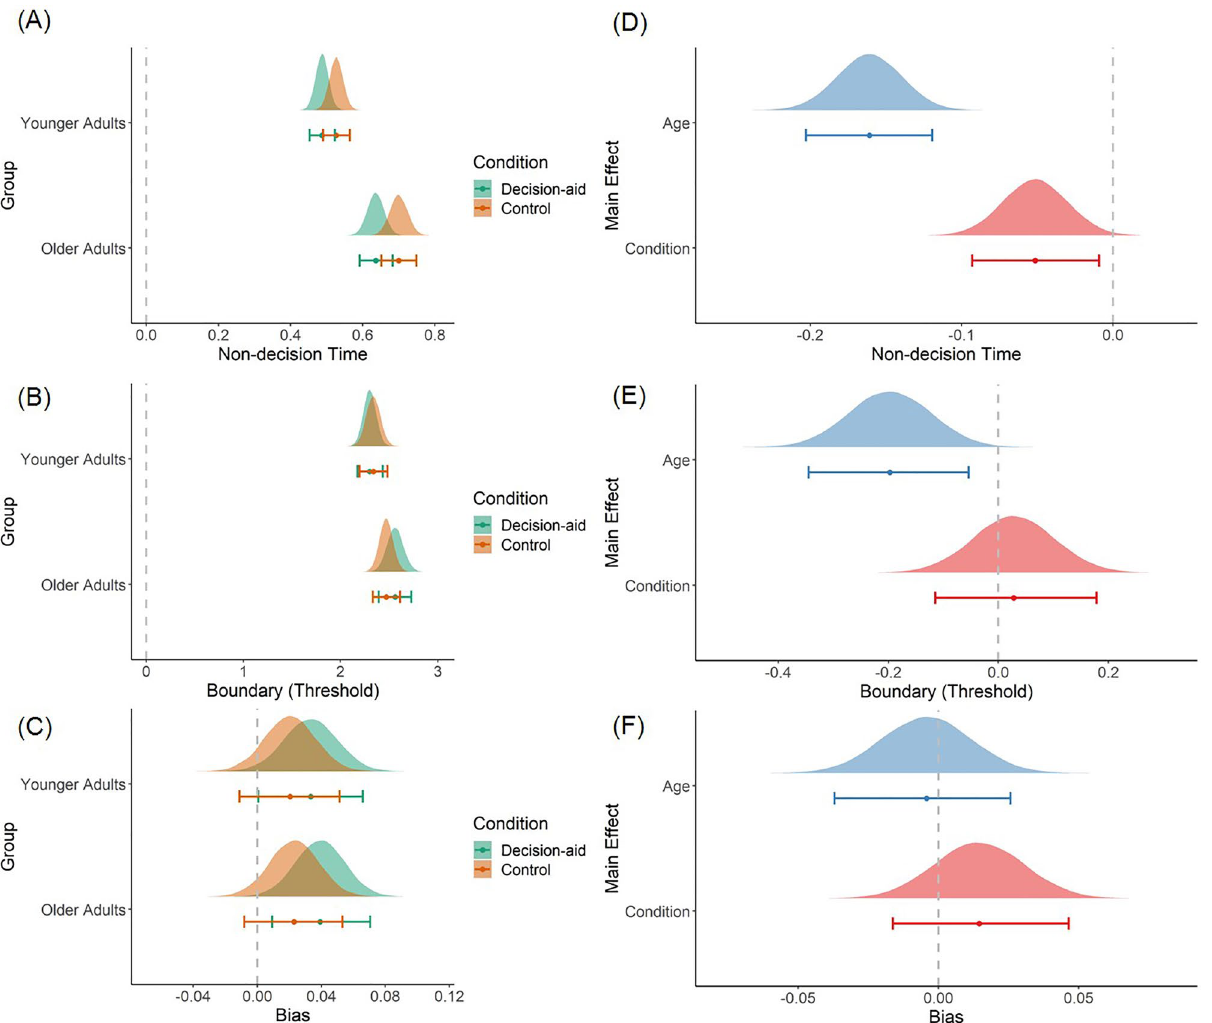
Figure 3. Effects of age group and condition on the non-decision time, boundary separation (threshold), and starting point bias parameters of stDDM (M3). ( A – C ) Posterior distributions of the group-level parameters from the best fitting model (M3) in all experimental conditions in both age groups. ( D – F ) Age and condition differences of the posterior distributions of the hyperparameters in the best fitting model (M3). Age group differences are shown as younger minus older adults. Condition differences are shown as aid minus control. Note. Dots and error bars shown below the distribution plots indicate the mean and 95% highest density interval, respectively. The distributions of the bias parameter are shifted by the parameter values minus 0.5 to have the same reference point at zero as other